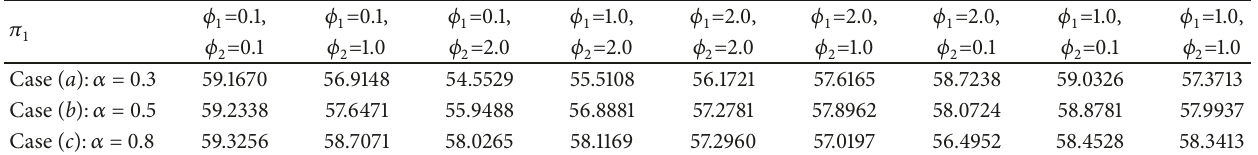
Table 3: The impact of fairness concern on player 1’s expected profit 𝜋 1 under three cases.